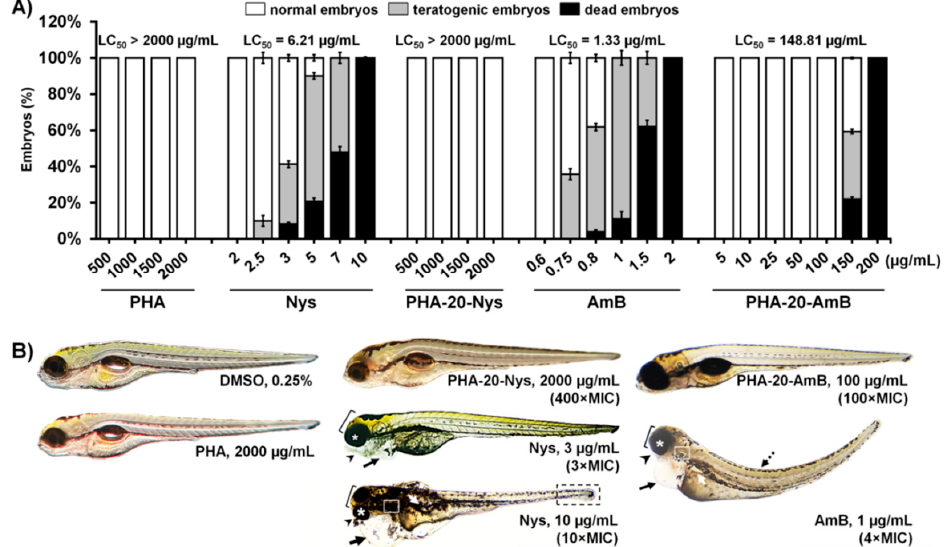
Figure 3. Polyene loading into PHA microspheres completely diminished inner organs toxicity caused by free polyene drugs. ( A ) Dose-dependent toxicity of the pure biopolymer (PHA), biopolymer-based polyene formulations (PHA-20-Nys and PHA-20-AmB) and free polyenes (Nys and AmB) in the zebrafish embryo model expressed as the LC 50 value (the dose killing 50% of the treated embryos). ( B ) Morphology of the 120-hpf old zebrafish larvae following different treatments over a course of 5 days. Toxic side effects are indicated as: pericardial edema (black arrow), edema in the kidney region (white arrow), malformed head (bracket), jaw (arrowhead), eyes (asterisk), otoliths (white box), curved tail (dashed arrow) and necrotic tissue in the tail region (black box). At 10 µg/mL Nys (10 × MIC), only one out of 90 embryos survived by 120 hpf, and was seriously malformed and moribund.